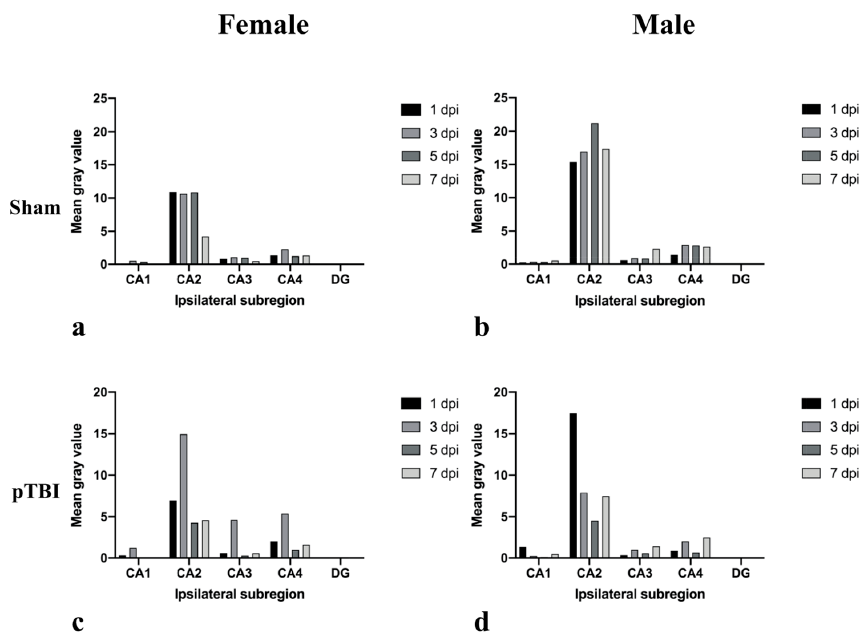
Figure 4. Overview of temporal changes in male and female hippocampal CYP1B1 mRNA expression in rats subjected to either sham-surgery or pTBI. Animals in Sham received a craniotomy, while animals in pTBI received a craniotomy with a subsequent pTBI. Survival times analyzed were 1-, 3-, 5- and 7 days. Graphs show timeline over CYP1B1 mRNA expression in females subjected to sham-surgery ( a ), males subjected to sham-surgery ( b ), females subjected to pTBI ( c ), males subjected to pTBI ( d ). CYP1B1 mRNA was detected by in situ hybridization. The mean gray value is presented in the Y-axis, showing the average mean gray area calculated from each measured cell for each subregion. To calculate mean gray value, images were made binary and in-situ probes made black and separated from the white background. The gray value of the color black was set to 255 and the value for white to 0. The gray value of each cell is therefore a measurement of the area of cell marked by the in-situ probe. The gray values from each cell of each subregion were then used to calculate the mean gray value of each subregion. The X-axis shows the ipsilateral subregions analyzed. In animals receiving pTBI, CYP1B1 mRNA expression is highest 1 dpi in males ( d ), whilst the highest expression in females is reached 3 dpi ( c ). The values are presented as means. Individual values and SD-values are presented in Figures 2, 3 and 5. Abbreviations: CA: Cornu Ammonis, CYP1B1: Cytochrome